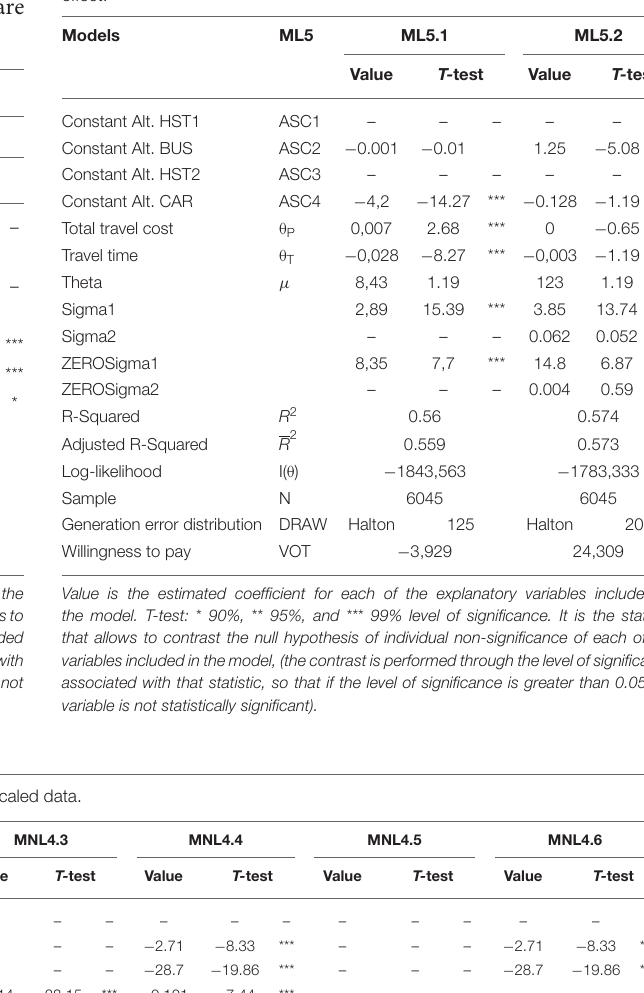
TABLE 5 | Results of ML models estimated with four alternatives, with panel effect.